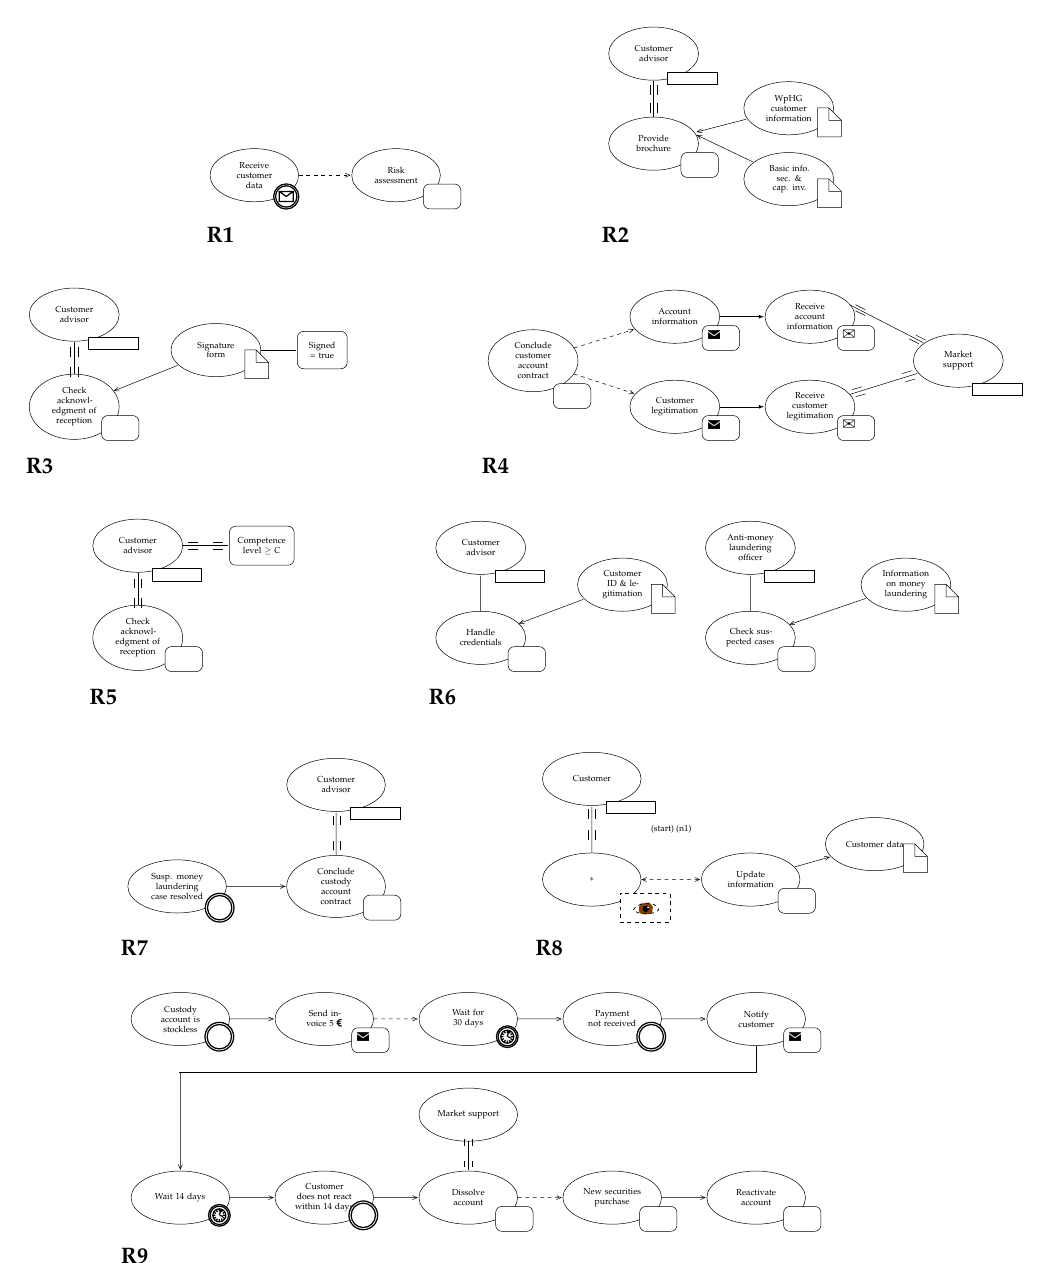
Figure 8. Formalised requirements in